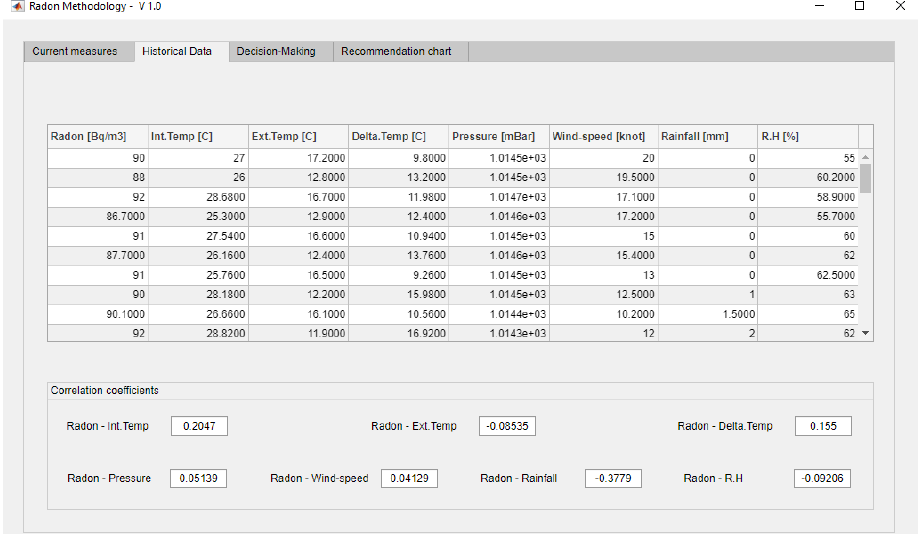
Figure 7. Dashboard for the calculation of the correlation coefficients.